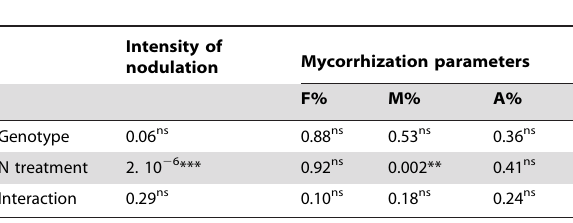
Table 3. Summary of statistical analysis (2- factor ANOVA) comparing the effect of genotype and N availability on the symbiotic microbial